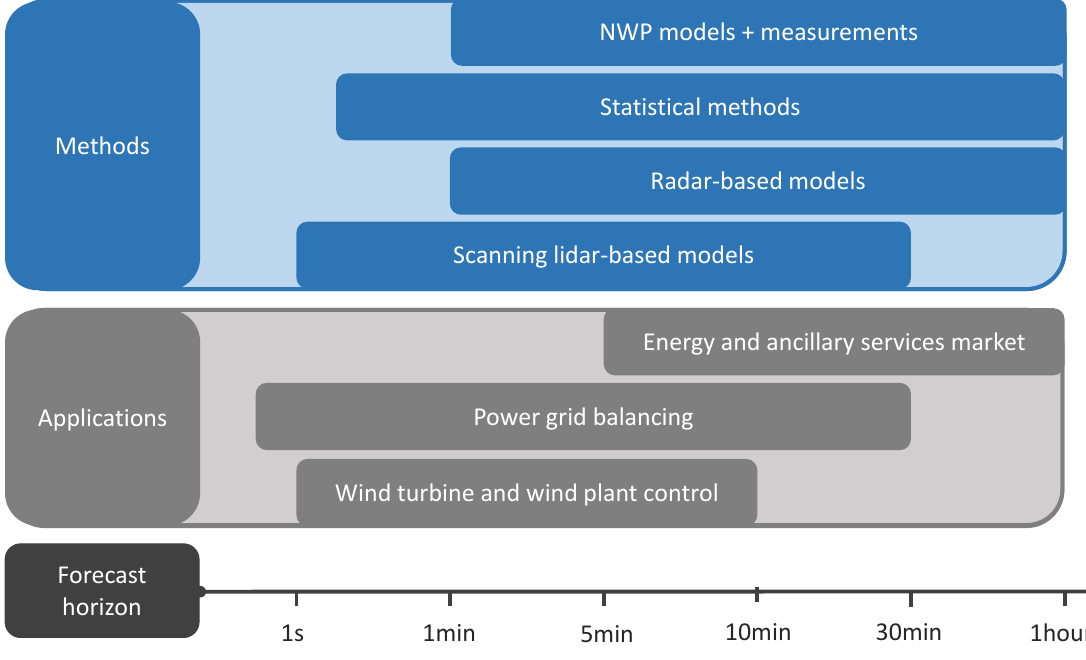
Figure 8. Overview of forecast horizons of different wind energy applications and forecast methods in the second and minute